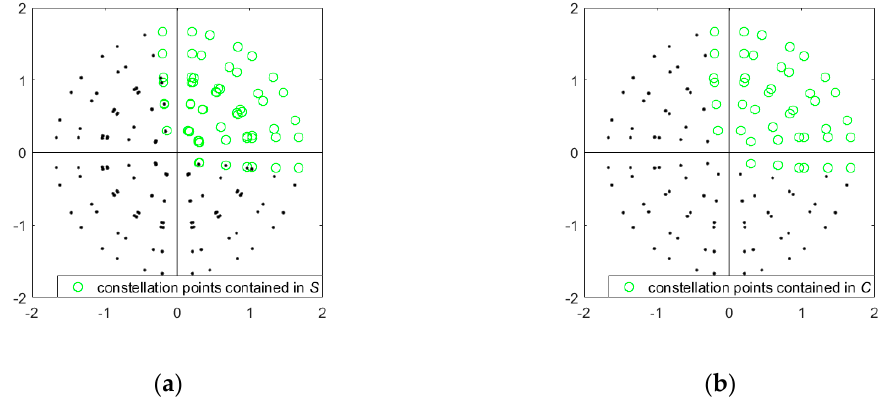
Figure 5. The subset of ED calculation when the received symbol is in the first quadrant. ( a ) Subset before using condensation characteristic; ( b ) Subset after using condensation